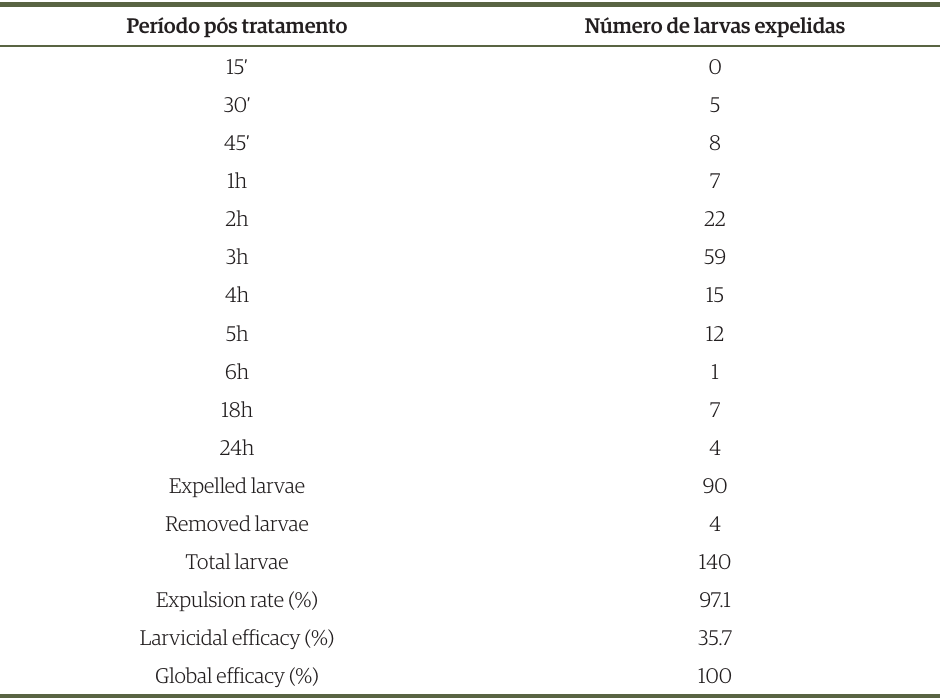
Table 1. Efficacy of nitempyram (Capstar®) against Cochiliomiyia hominivorax larvae in ocular myiasis of a naturally infested